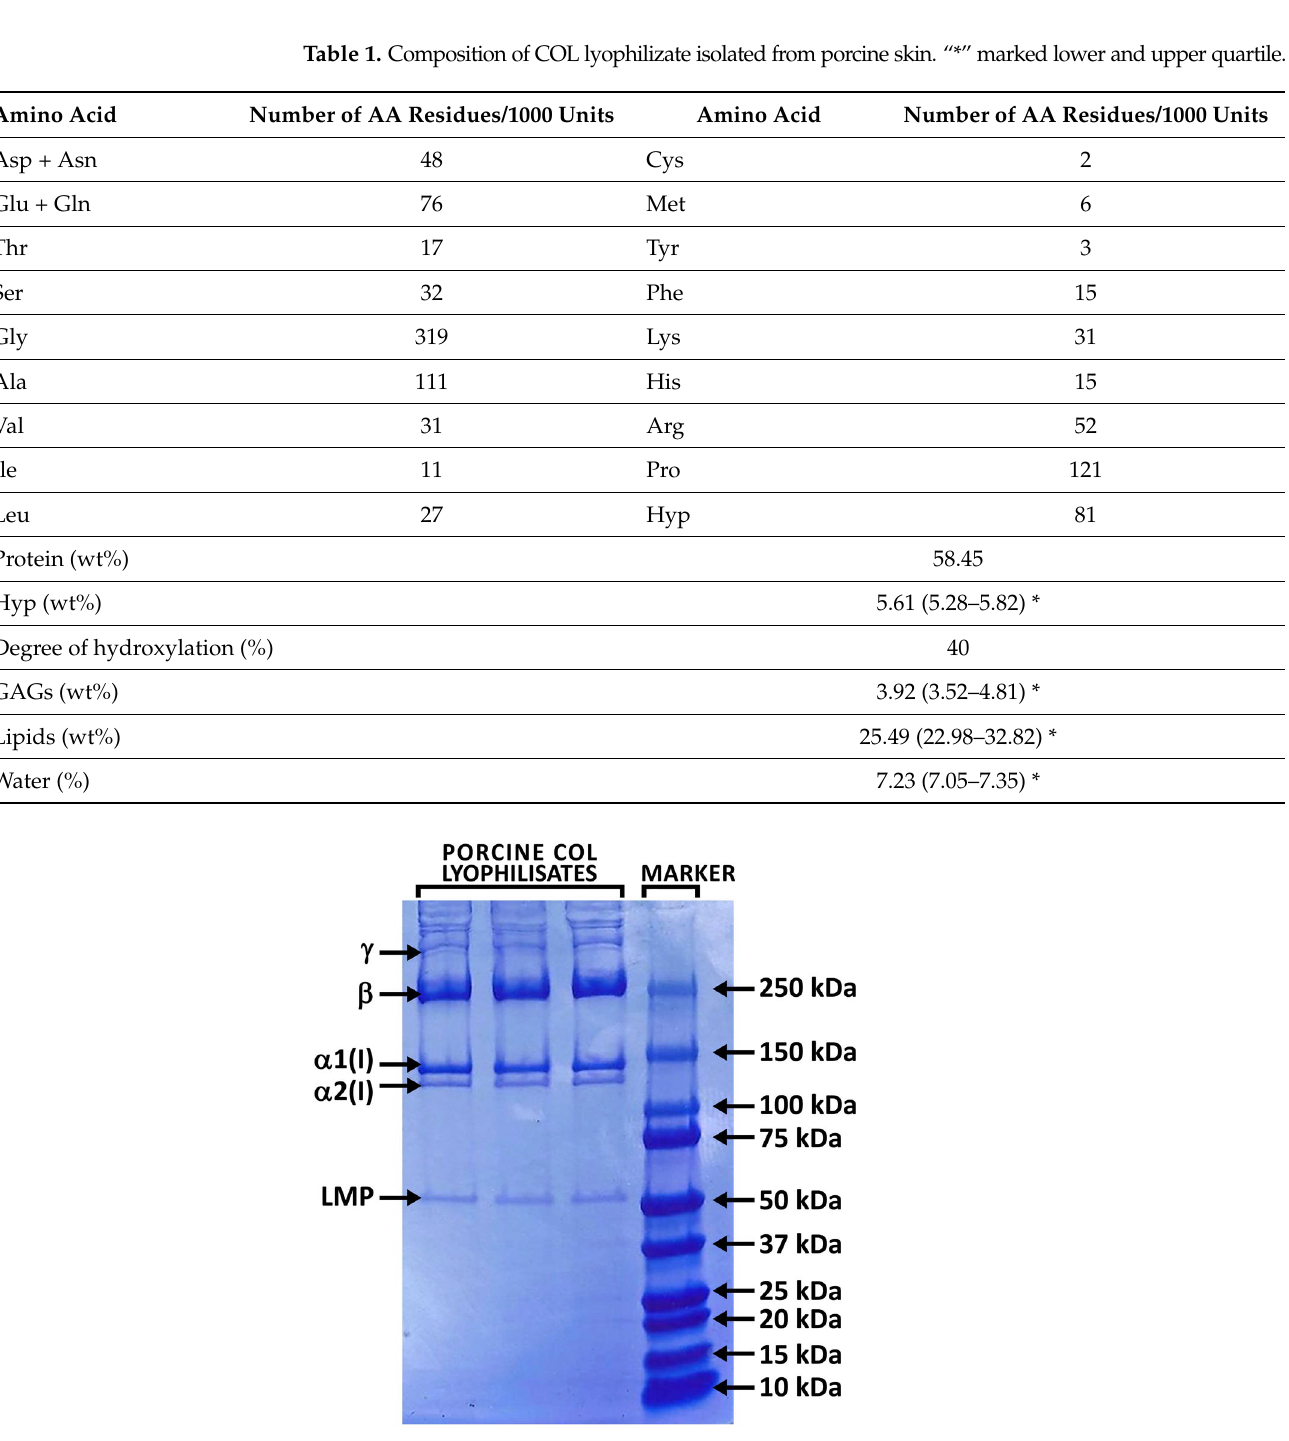
Figure 1. Polypeptide pattern of COL I type isolated from porcine